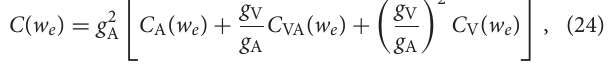
0.7 and g eff A ≈ A ≈